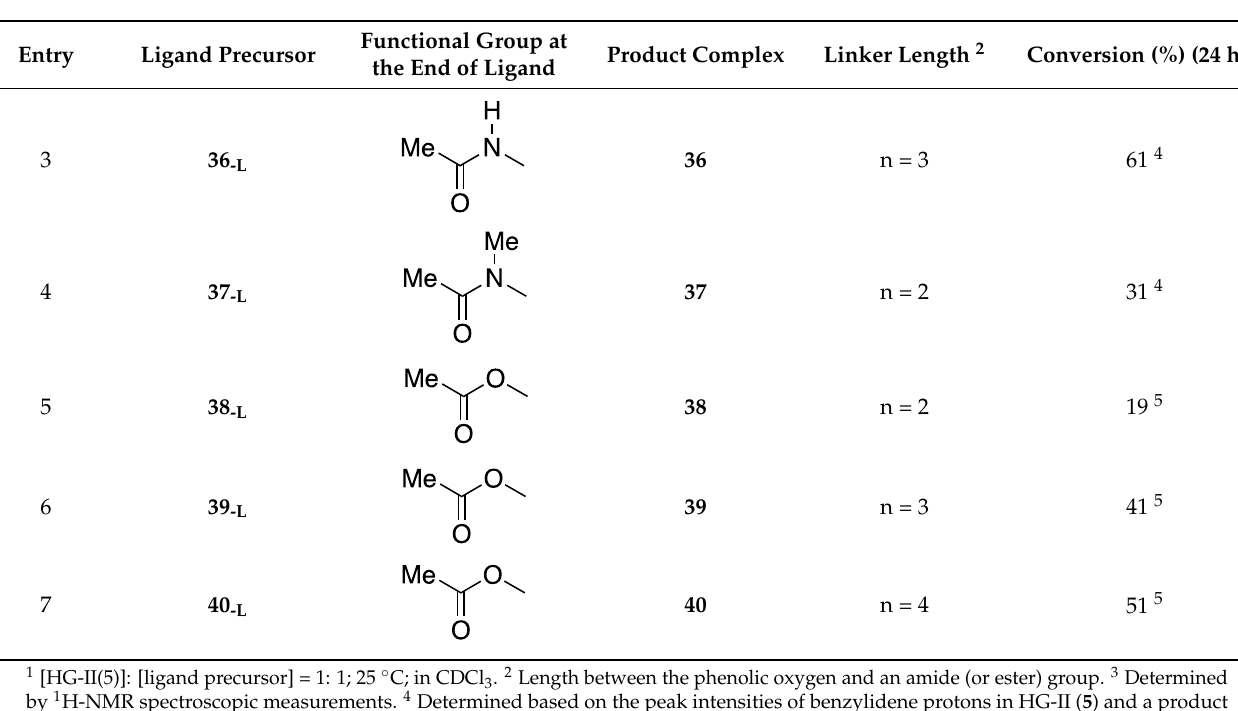
Determined by 1 H-NMR spectroscopic measurements. 4 Determined based on the peak intensities of benzylidene protons in HG-II ( 5 ) and a product complex. 5 Determined based on the peak intensities of the i Pr-Me protons in HG-II ( 5 ) and the Me (or t Bu) protons in a product complex.